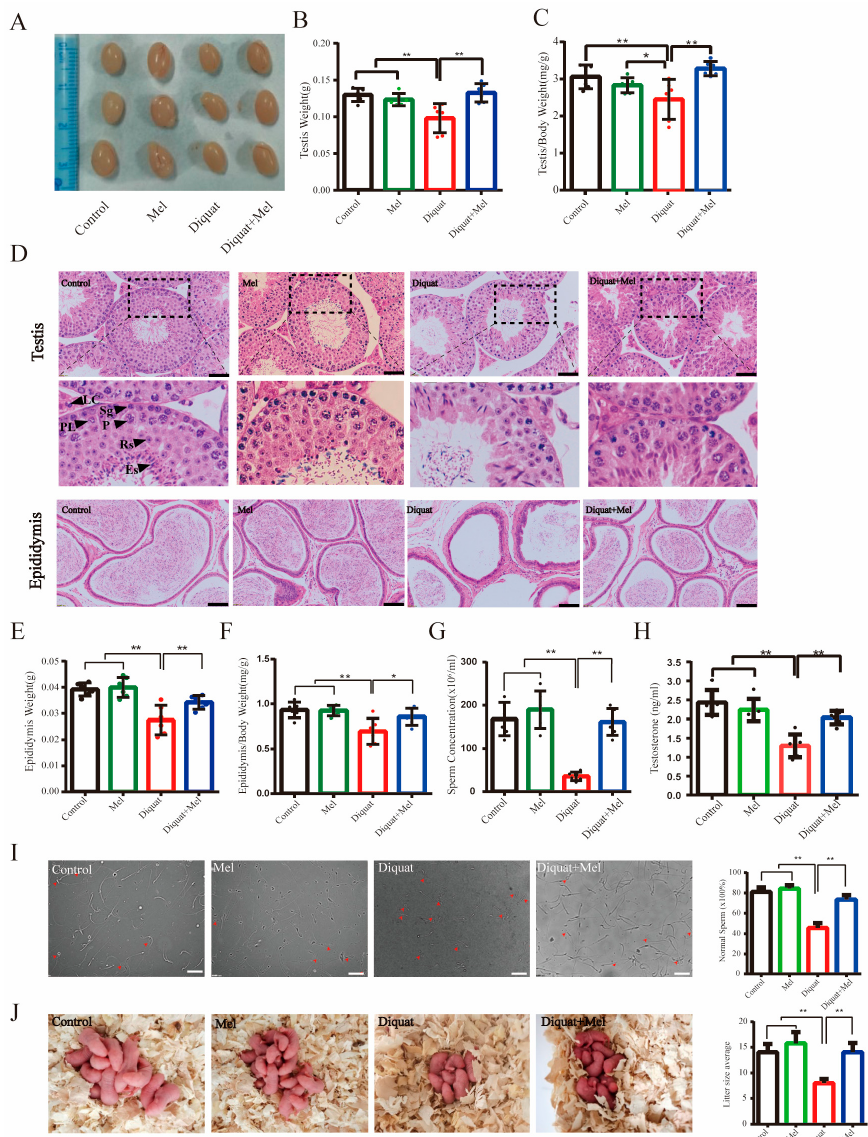
Figure 1. Melatonin ameliorates spermatogenic failure induced by diquat in mice. Male mice were intraperitoneally injected with ethanol (control), melatonin (10 mg/kg/d), diquat (10 mg/kg/d), or diquat combined with melatonin for 28 consecutive days: ( A ) image of testes; ( B ) weights of testes and ( E ) epididymides; ( C ) organ coefficients of testes; and ( F ) epididymides in respective treatment groups; ( D ) morphology of testes and epididymides in the different groups. The squares represent the enlarged position in the following figure. Sp: spermatogonium; PL: preleptotene spermatocyte; P: pachytene spermatocyte; Rs: round spermatids; Es: elongated spermatids; LC: Leydig cells. Scale bars = 50 µ m; ( G ) sperm concentration in the cauda epididymides of mice under different treatments; ( H ) serum testosterone concentration in different treated groups; ( I ) sperm morphology and the percentage of normal sperm per epididymis. Red arrowheads denote abnormal sperm. Scale bars = 50 µ m; and ( J ) the graph and number of offspring in different treatments males. Data are presented as the mean ± SEM of at least three independent experiments. * p < 0.05, ** p < 0.01.